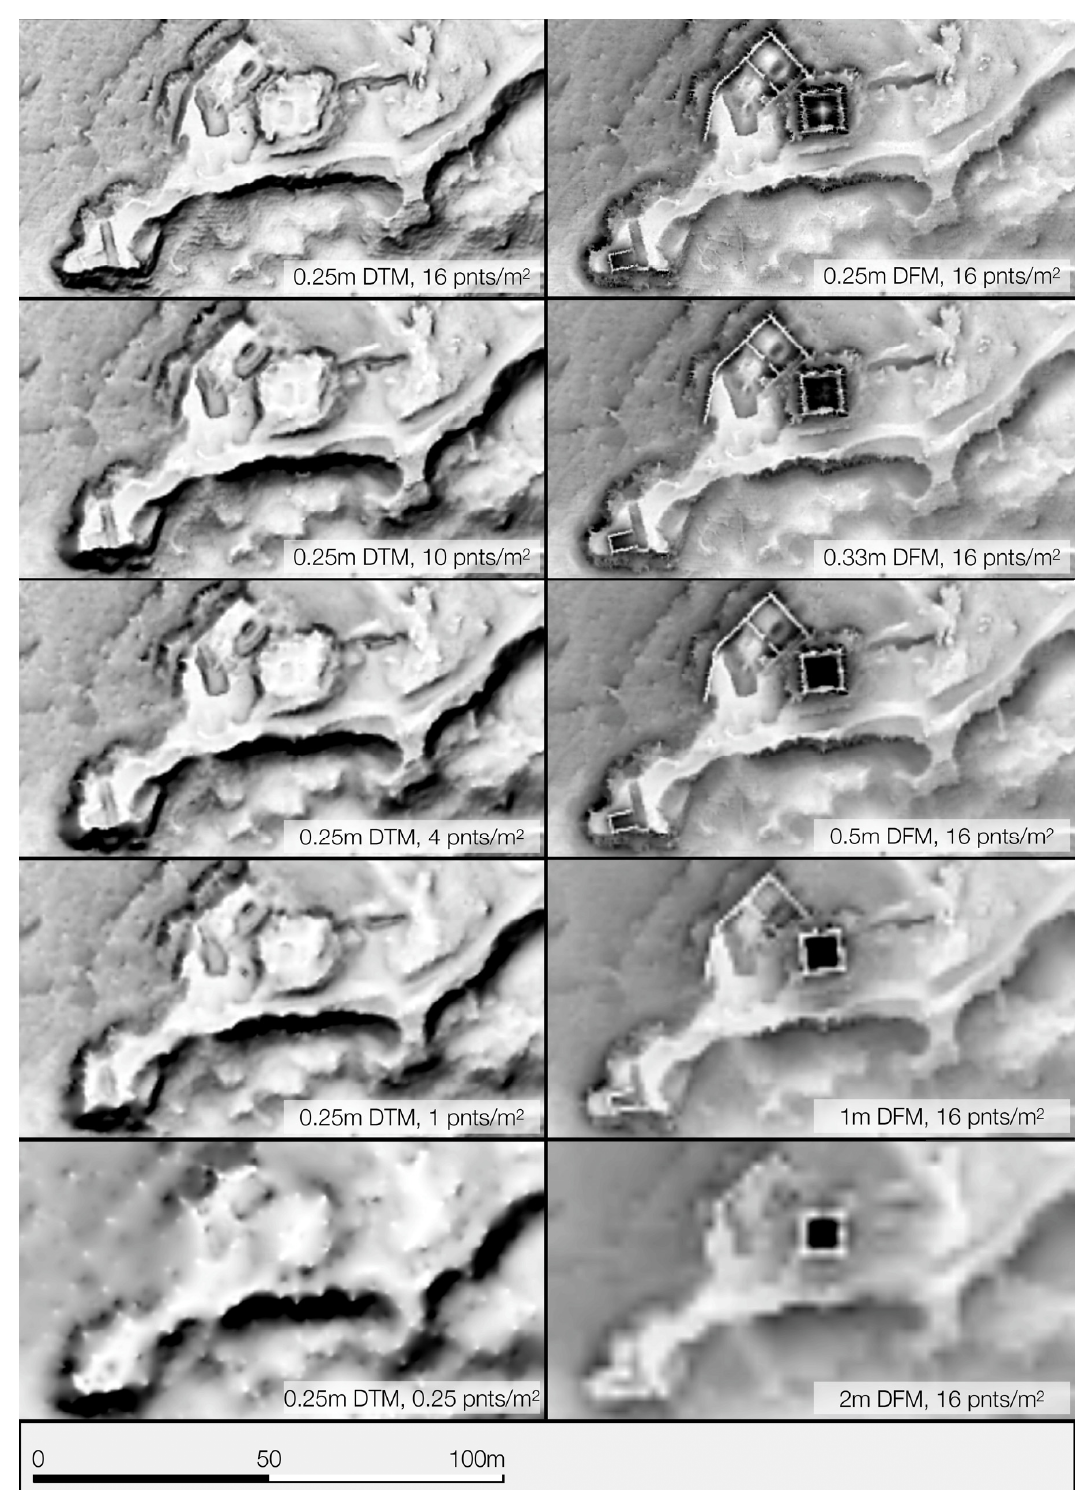
Figure 6. Test site AT, the effects of reducing ground point density ( left ) and reducing DFM resolution ( right ). The ground point density and DEM/DFM resolution are indicated in each image. The processing pipeline is the same for all instances (point cloud processing according to [1]; OK interpolation; sky view factor visualization with default settings in RVT v.2.2). However, to demonstrate the effect of reduced point density on ground point filtering, the data in the left column lacks manual